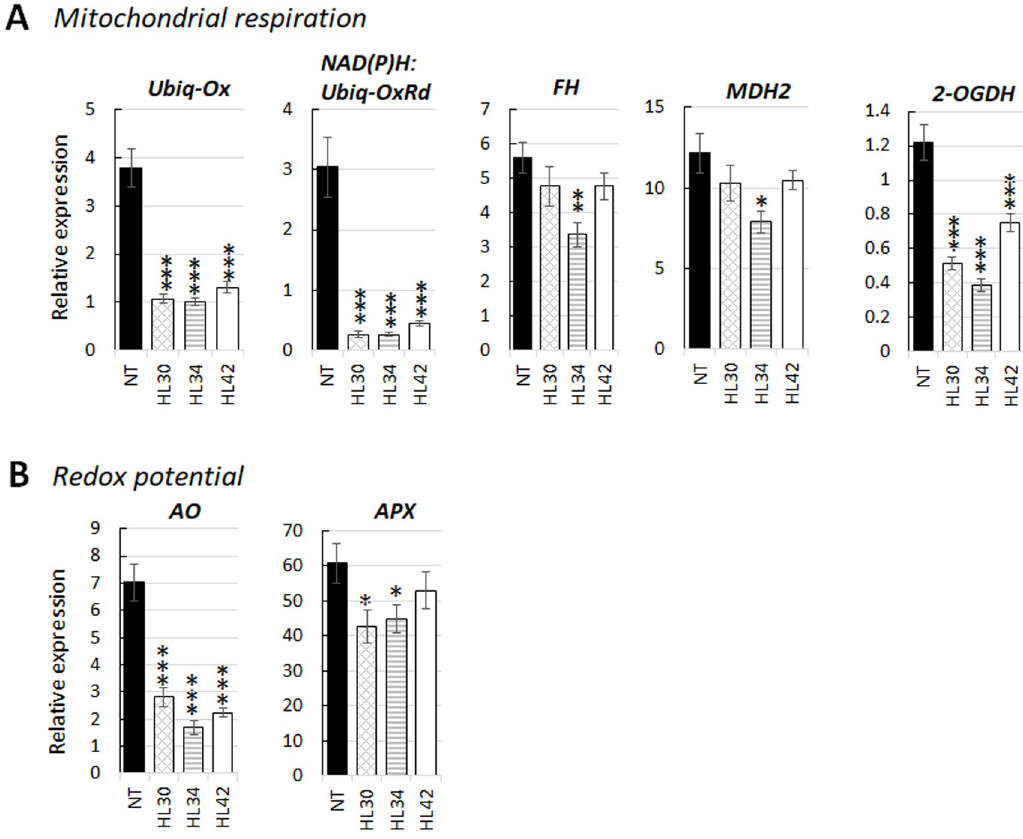
Fig 5. Validation of selected genes in high lipid (HL) lines and non-transformant (NT) plants for relative expression. � indicates p < 0.05, �� for p < 0.01 and ��� for p < 0.001 (Student’s t-test). Bars represent the means and SE of five biological replicates. Selected DEGs grouped using Gene Ontology analysis as following: A Mitochondrial respiration: Ubiquinol oxidase ( UbiQ-Ox , XP_015635413.1); alternative NAD(P)H: Ubiquinone oxidoreductase ( UbiQ-OxRd , XP_015637913.1); fumarate hydratase ( FH , XP_015633139.1); malate dehydrogenase 2 ( MDH2 , XP_015621604.1); and 2-oxoglutarate dehydrogenase ( 2-OGDH , XP_015646480.1). B Redox potential: L- ascorbate oxidase ( AO , XP_015611052.1); L- ascorbate peroxidase ( APX ,